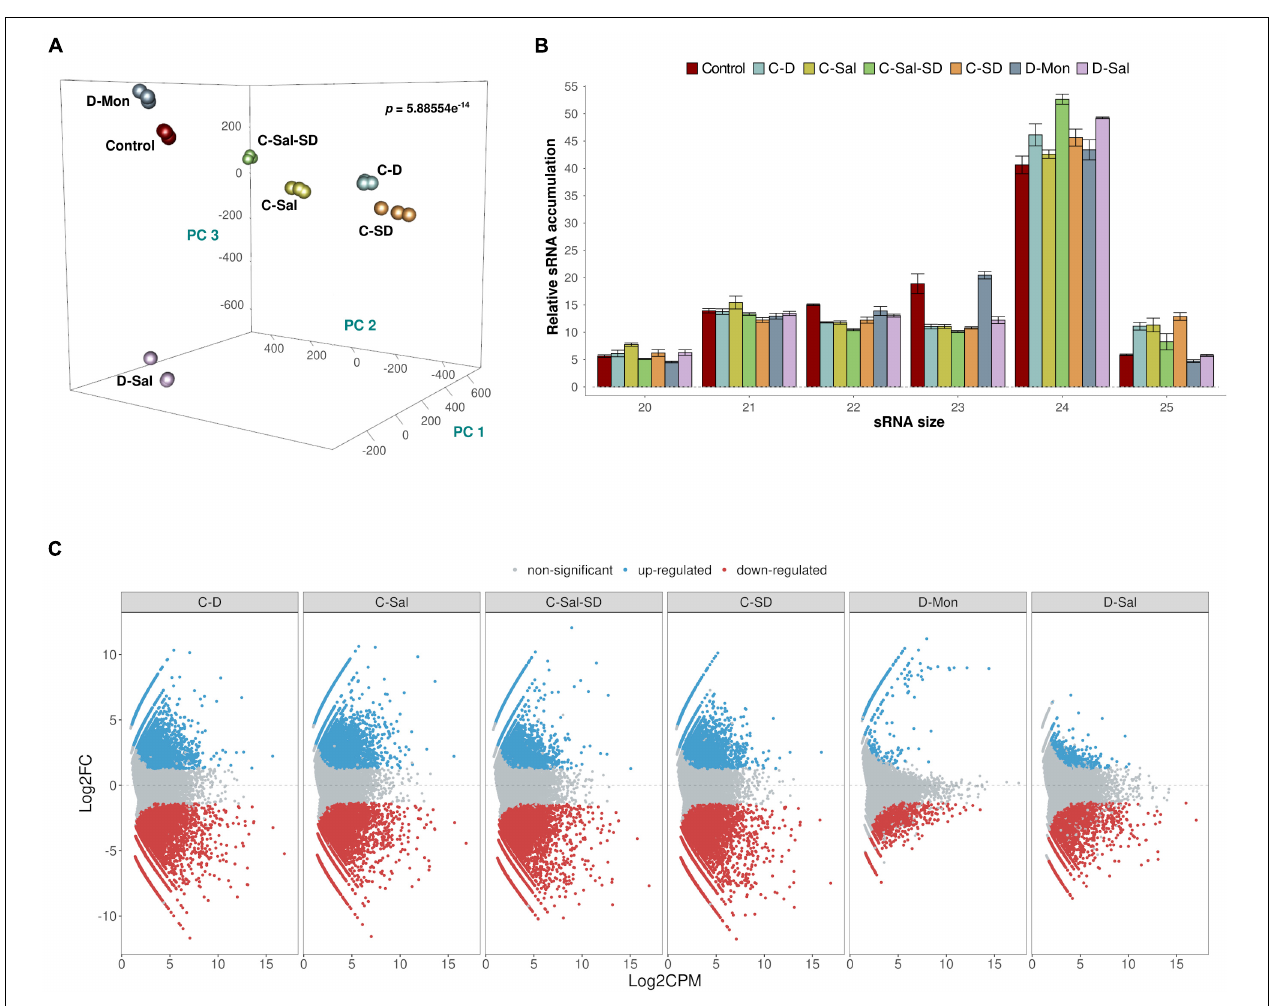
FIGURE 1 | Analysis of the sRNA populations. (A) PCA based on sRNAs accumulation in three biological replicates of melon plants exposed to the six stress-combined treatments and controls. The statistical significance ( p = 5.886 × 10 – 14 ) was estimated by Mann–Whitney–Wilcoxon test, considering the inter- and intragroup Euclidean distances. (B) A diagram showing the relative accumulation (and distribution of the total clean reads of melon sRNAs ranging between 20 and 25 nt obtained from the analyzed sequenced libraries. The control and the different analyzed treatments are represented with colors. The shown values represent the sum of all repetitions. Bars indicate the standard error. (C) Graphic representation of the expression values (estimated by edgeR) of sRNA sequences recovered from melon exposed to different stress conditions. The dots indicate the expression value of each sRNA. Red and blue dots indicate significant values for differential expression with | log 2 FC | ≥ 1.25, respectively. Gray dots indicate sRNAs with non-significant differential expression.